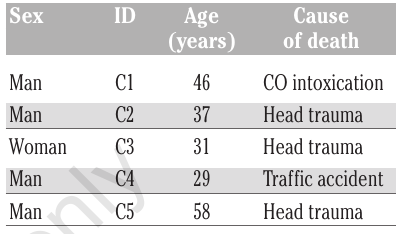
Table 4. Control patient characteristics.